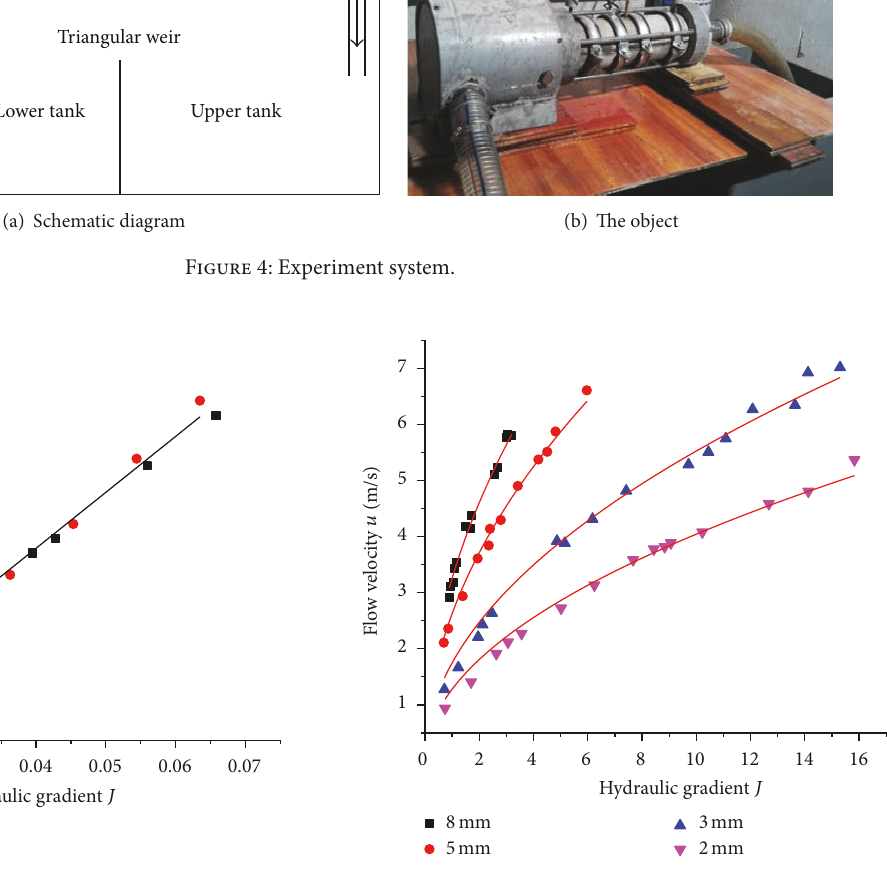
Figure6: Relationship between flowvelocity andhydraulic gradient at different fracture